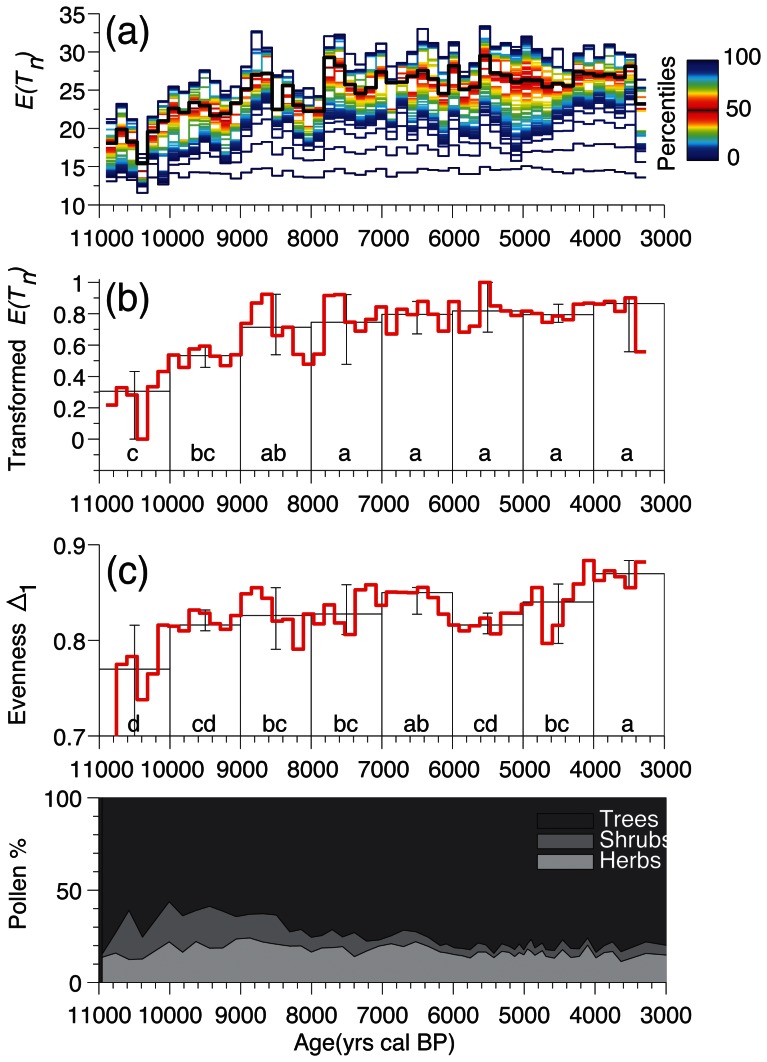
Pollen richness E(Tn) inferred based on the rarefied and resampled pollen record from Lac de Fully.(a) E(Tn) of all 500 simulations with median as black continuous line and percentiles (see legend) as coloured lines; (b) Minimax rescaled median E(Tn). (c) Evenness (Δ1) based on the probability of interspecific encounter. The bars in (b) and (c) indicate the median E(Tn) and Δ1 for 1000-years windows, vertical whiskers indicate the full range of E(Tn) and Δ1 in each time period; letters (a-d) illustrate significant differences from the post hoc least significant difference tests (two different letters indicate a significant difference at the p = 0.05 level). (d) Cumulative pollen percentages of trees, shrubs and herbs.